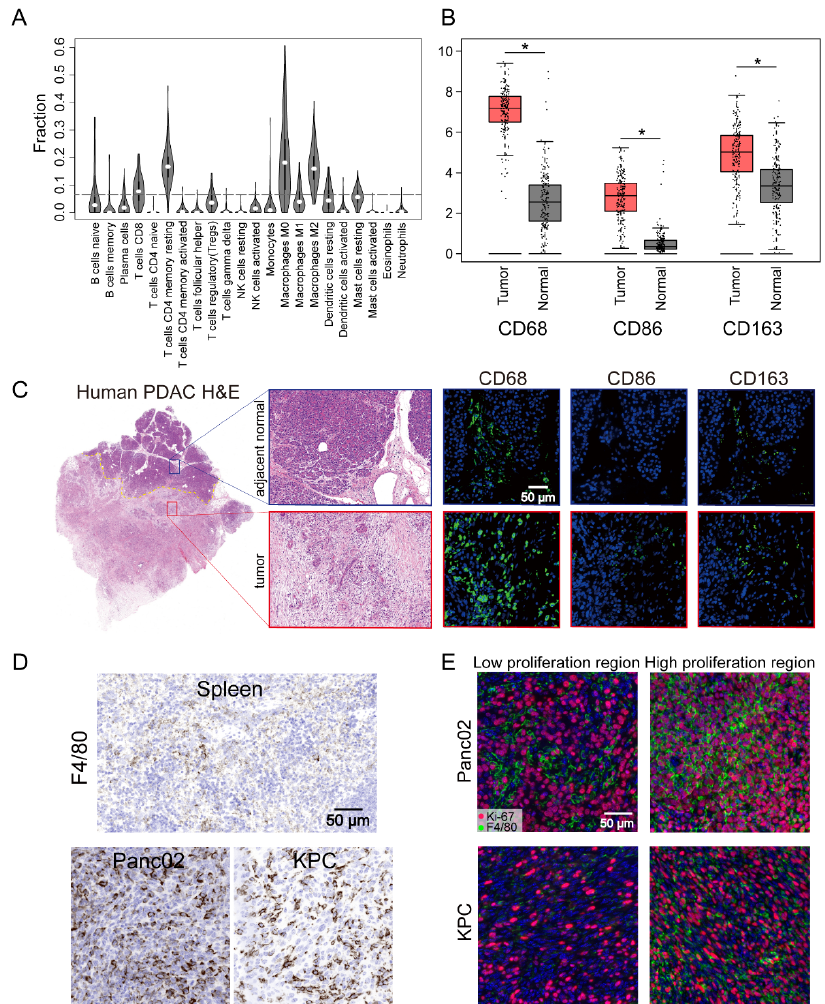
Figure 1. Pancreatic ductal adenocarcinoma (PDAC) tumors were highly infiltrated by macrophages. ( A ) Tumor ‐ infiltrating immune cell abundance profiles determined by using a violin plot showing the ratio differentiation of 22 kinds of immune cells in PDAC tumor samples ( n = 178) from the TCGA ‐ PAAD datasets. ( B ) The transcriptome data from GEPIA database showed that CD68, CD86, and CD163 were more highly expressed in PDAC tissues ( n = 179) compared with normal tissues ( n = 171). ( C ) Representative images of human PDAC and adjacent normal pancreatic tissues assessed for macrophage density (CD68, CD86, or CD163). ( D ) Representative IHC images of pancreatic tissue from the KRAS and p53 mutants (KPC) and Panc02 mouse models showing a high infiltrated macrophage (F4/80) density in comparison to that in images of spleen tissues. ( E ) Representative immunofluorescence images of Ki ‐ 67 + F4/80 staining in Panc02 and KPC tumors. Statistical analyses were carried out by Student’s t test. *: p ≤ 0.05.